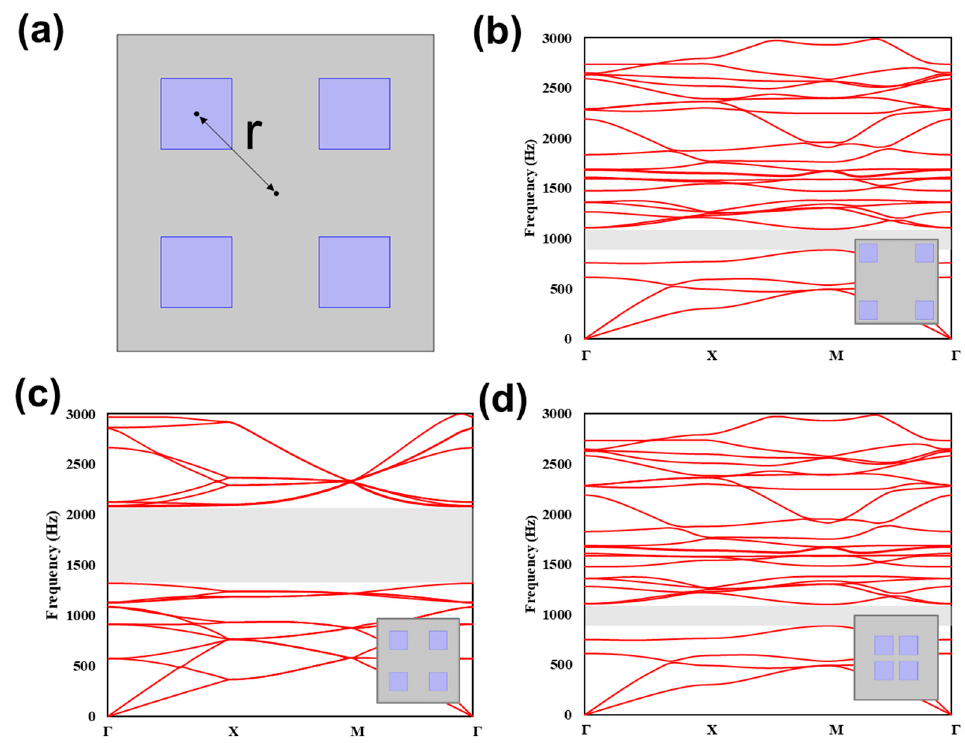
Figure 6. ( a ) Phononic crystal with four-square inclusions at a filling fraction of 0.2, where the location of the inclusions were varied by changing the distance r. The dispersion curves showing the generated band gaps are plotted in the case of ( b ) r = 0.495, ( c ) r = 0.354, and ( d ) r = 0.212.